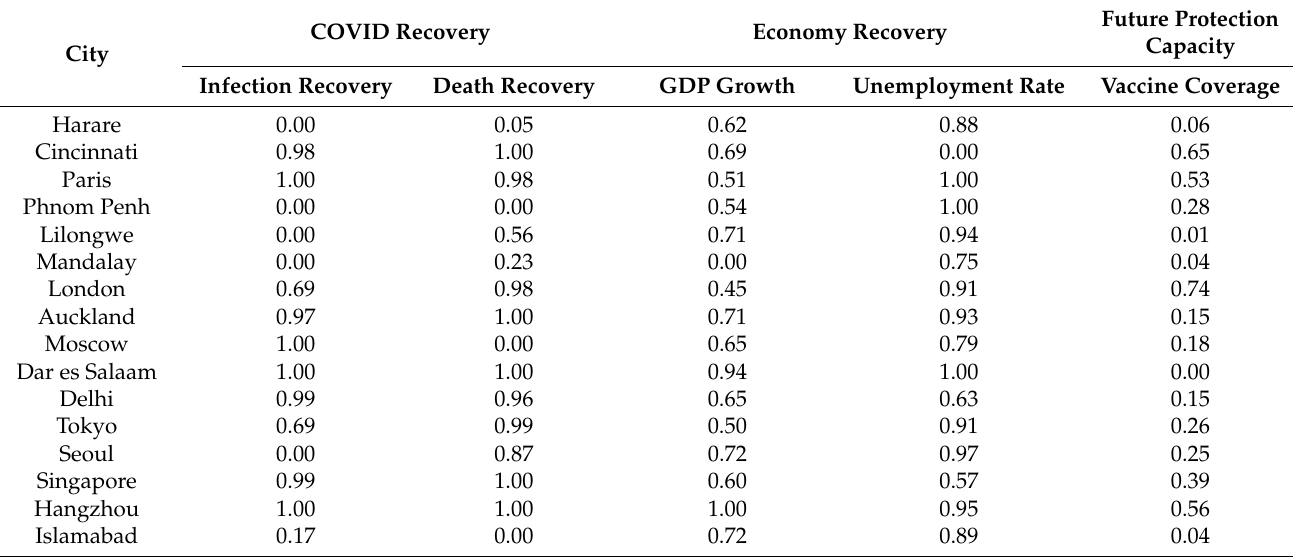
Table 3. Summary of indicators included in recovery outcome index.